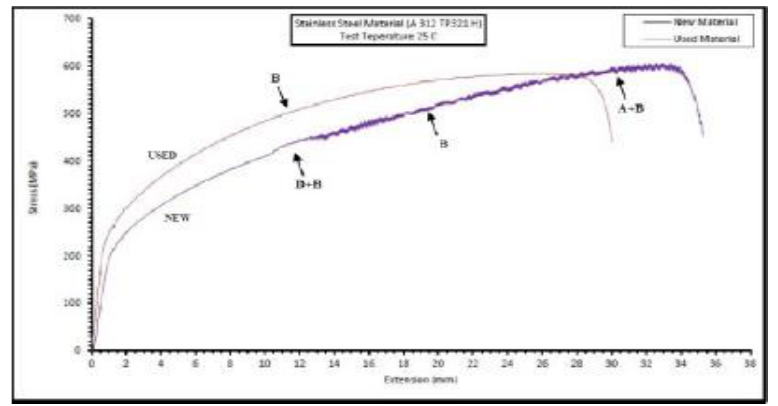
Fig. 9 Stress-strain curve at room temperature for un-used and ex-used stainless steel 321H.